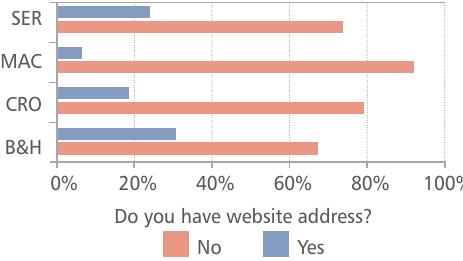
FIGURE 4. The use of websites and email addresses (sample size: 30 companies in B&H; 71 companies in Croatia; 36 companies in Macedonia; 91 in